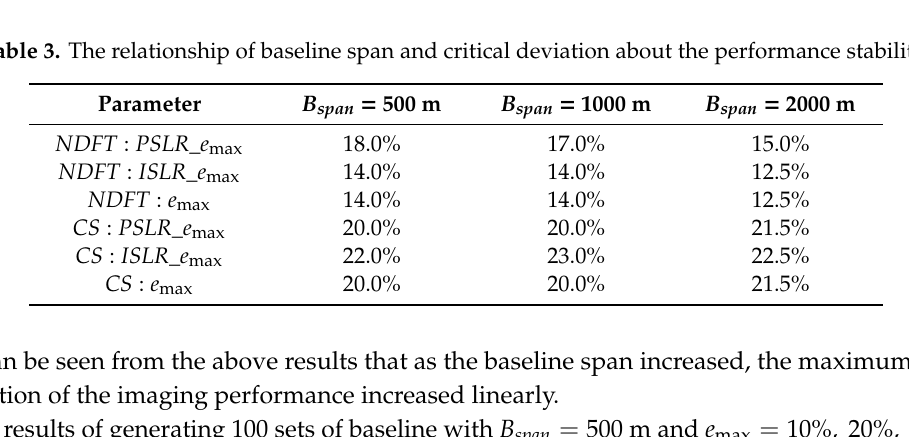
Figure 9. The imaging performance with B span = 2000 m: ( a ) PSLR; ( b ) ISLR.